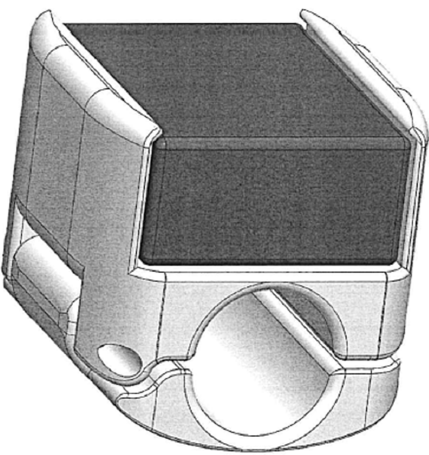
Figure 14. Rendering of the clamping system design for the installation of sensor nodes on the conductors.